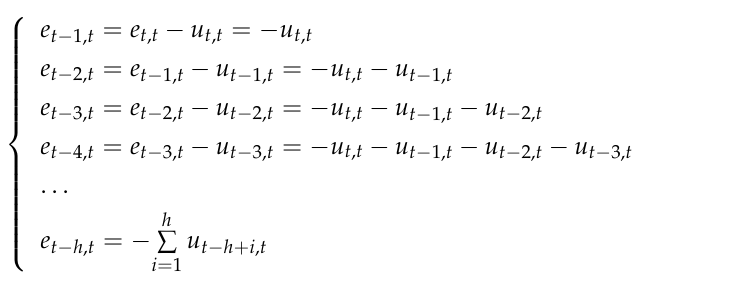
u where , q t represents the reduction in the forecasting error at time riod with respect to the error at time